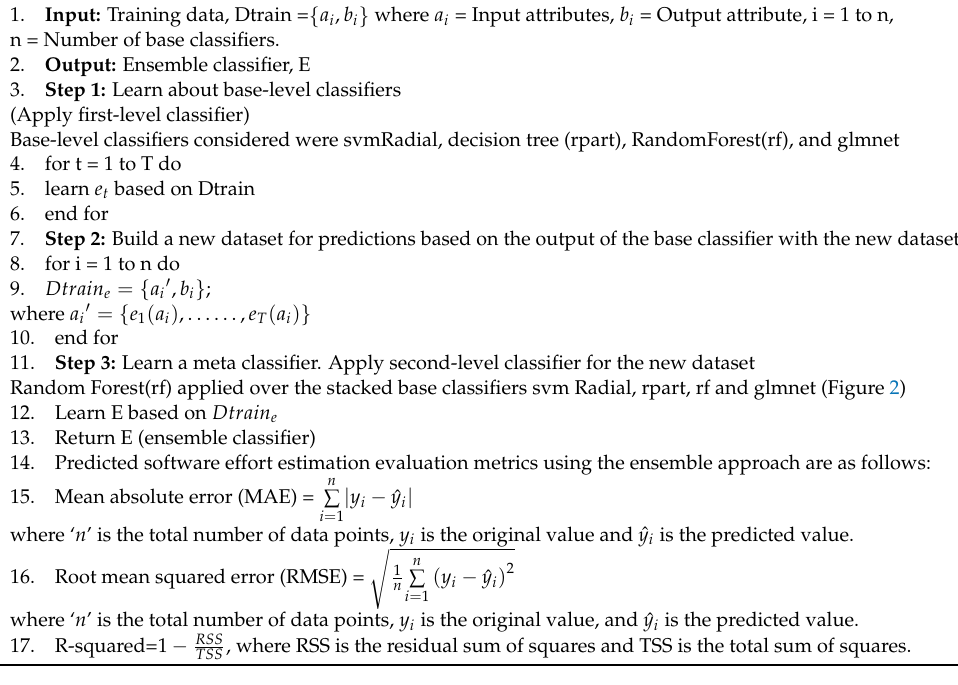
Algorithm 1. Pseudocode of proposed stacking using random